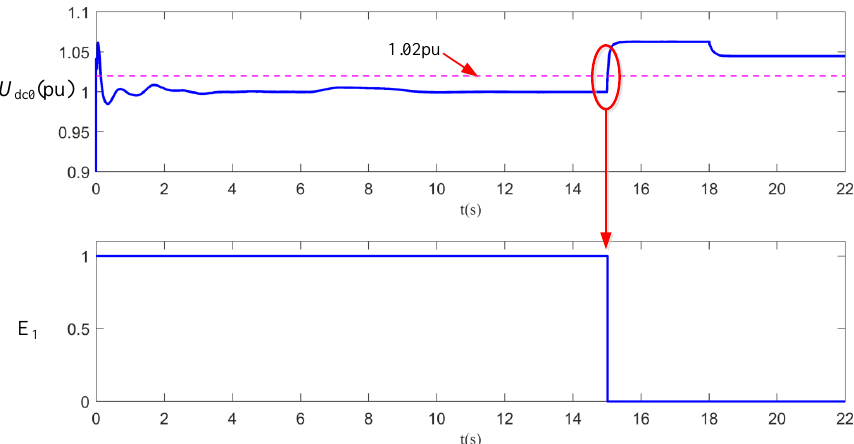
Figure 13. MVDC bus voltage and enable signal of the original voltage loop in isolated DC/DC converter 1. converter 1.